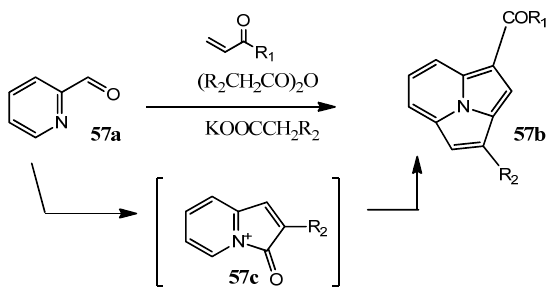
In brackets—yield of benzoindolizine. A—diphenyliodonium-2-carboxylate mono-